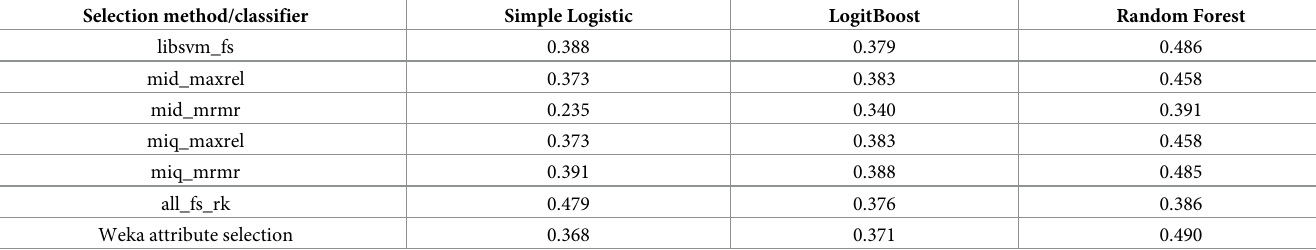
Table 3. The cross-validation results of each classifier in stage 1 with different feature selection methods. Selection